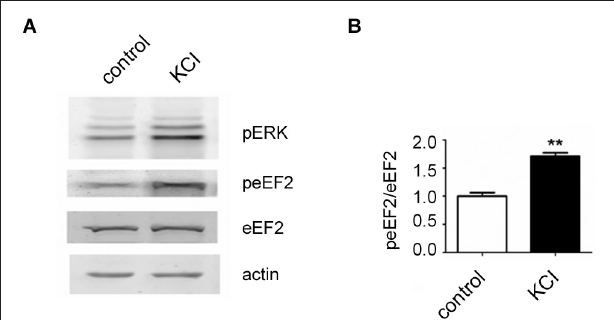
FIGURE 1 | Increase of eEF2 phosphorylation on Thr56 in neurons by KCL. (A) Western blot analysis of neuronal lysates reveals a strong upregulation of phosphorylated ERK and eEF2 upon KCL treatment. Neuronal cultures were prepared from day 18 rat embryos (Charles River) and plated at medium density (200 cells/mm 2 ) on 12-well plates and cultured with home-made B27 according to a protocole previously described (Romorini et al., 2004). At days in vitro 18, neurons were pretreated with TTX (1 µ M) for 12 h and treated with KCL (55 mM) for 5 min. A strong increase of phosphorylated ERK on Thr202 and Tyr204 (pERK) and phosphorylated eEF2 on Thr56 (peEF2) can be appreciated. (B) Quantifications of normalized peEF2 band intensities (peEF2/eEF2) (vertical axis shows the mean fold change vs. control). Error bars are SEMs; ** p < 0.01 vs. control (student’s t